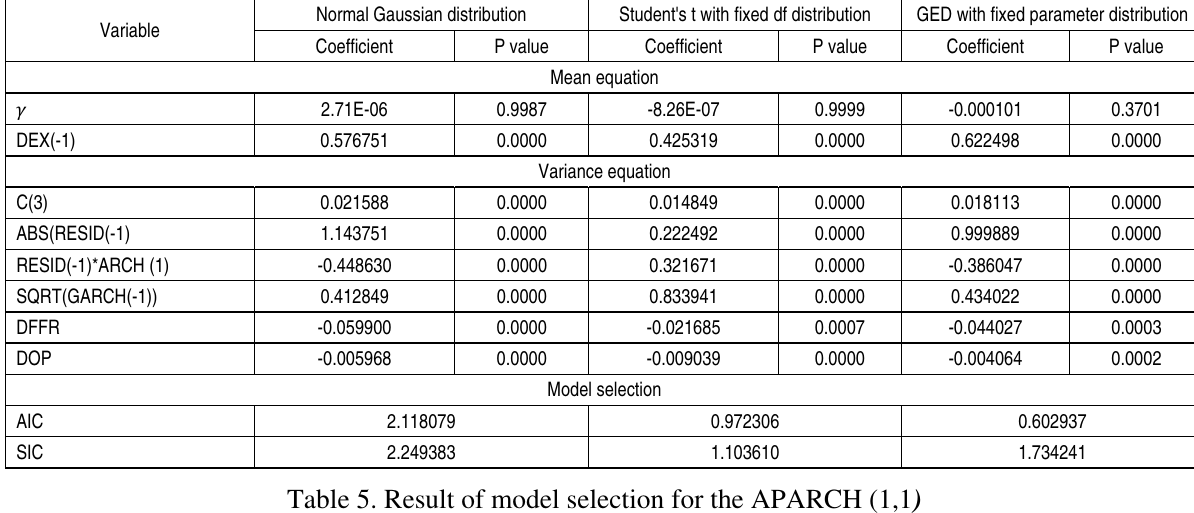
Table 4. Result of APARCH (1,1) model